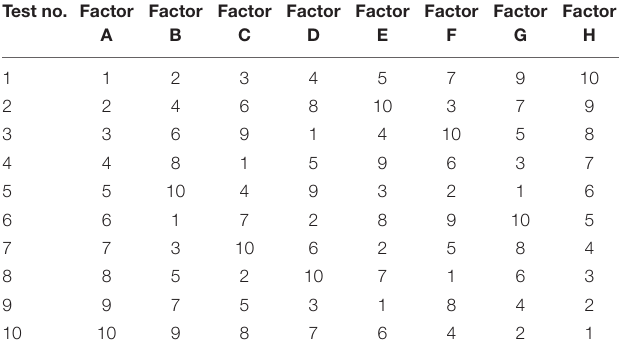
TABLE 5 | U ∗ 10 (10 8 ) uniform test design.